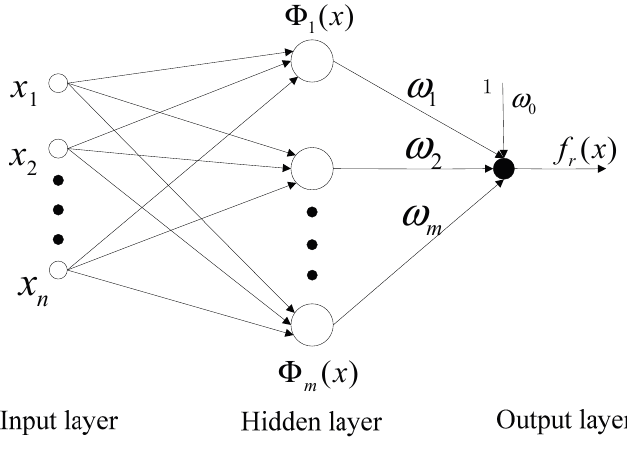
Figure 1. Typical structure of the radial basis function neural network